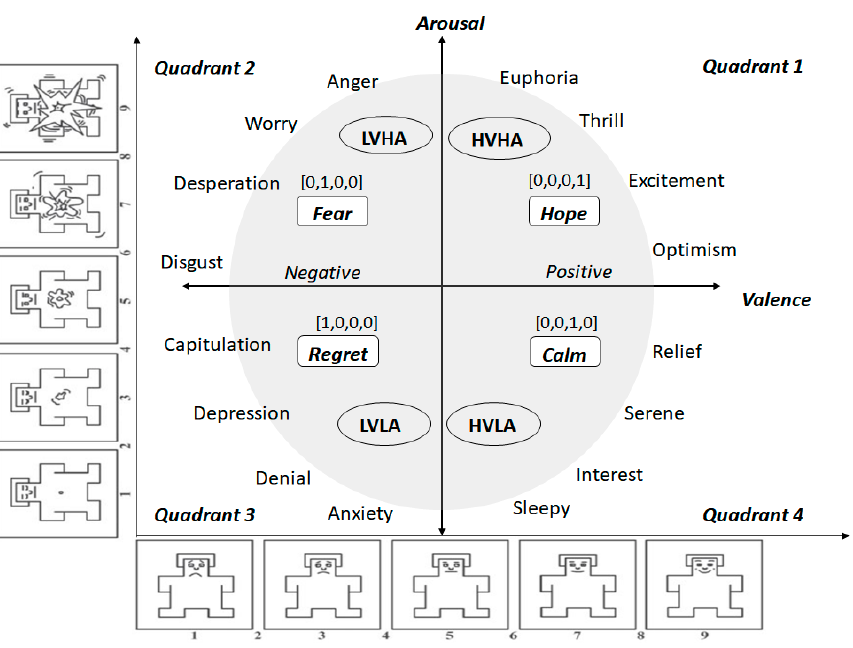
Figure 2. A schematic illustration of the self-labeling of emotions using SAM within the framework of valence and arousal. of valence and